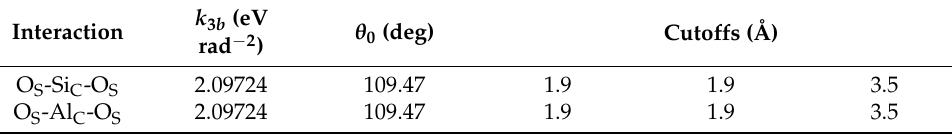
Table 4. Parameters of the three-body harmonic potentials used in this